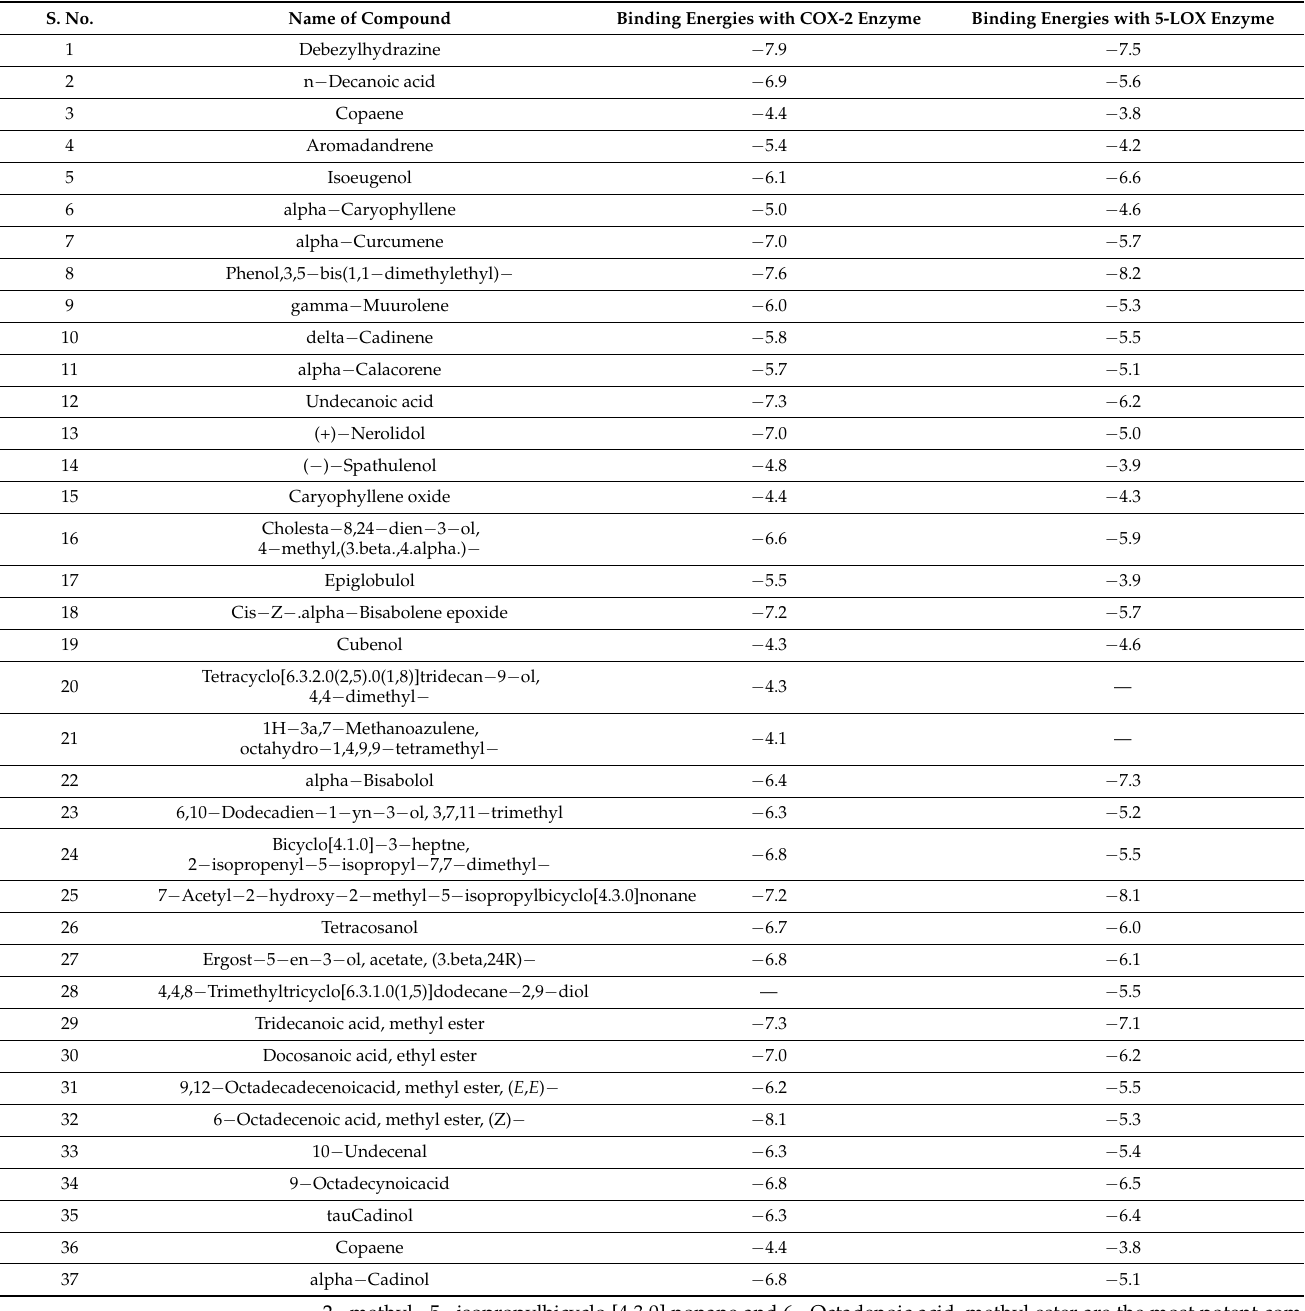
Table 5. Binding energies of compounds docked with COX-2 and